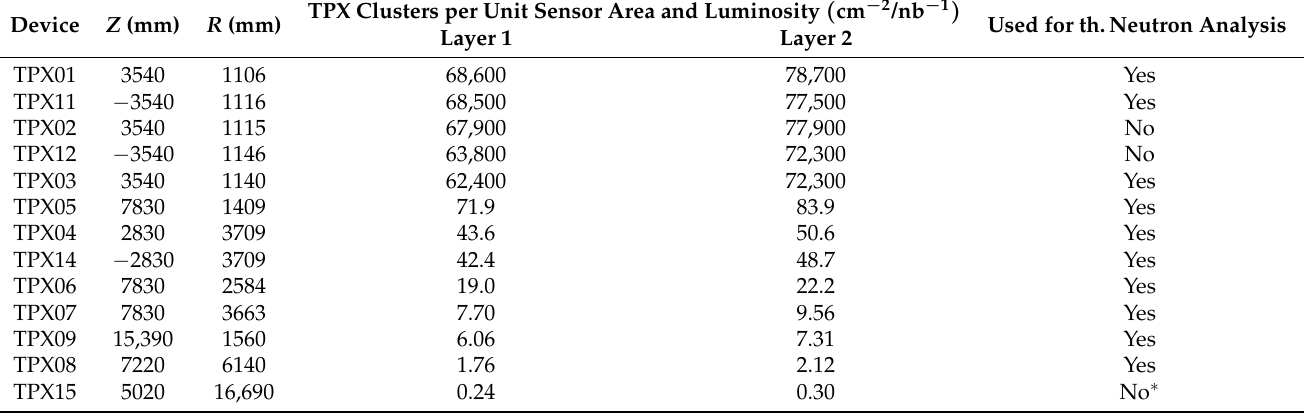
Figure 53. Time history of the TPX luminosity using thermal neutron counting. The descending LHC luminosity curve is clearly visible. The error bars give the statistical uncertainty. The normalization between hit rate and luminosity is based on the vdM scan using LHC fill 4266, determined with the TPX hit-counting [14], and details are given in the text and in Figure 54. The small dip at 0:30, visible as variation from the descending curve, corresponds to the time when the LHC operators performed small-amplitude beam separation scans to optimize the luminosity. Taken from Ref. [17]. Table 27. TPX device locations with respect to the interaction point. Z is the longitudinal distance from the interaction point, and R is the distance from the beam axis. Their uncertainty is about 10mm. The ordering in the table is given with decreasing particle fluxes, normalized to 100% acquisition time. Only devices operated for cluster counting throughout the year 2015 are used for the heavy blob (thermal neutron) analysis, as indicated. ∗ Rejected during analysis because of a too small count rate. Taken from Ref.